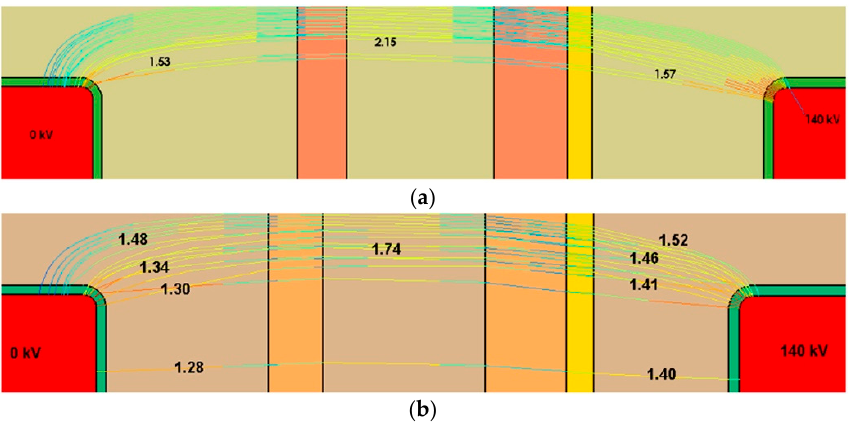
Figure 13. Safety factors, top terminal: ( a ) ester; ( b ) mineral oil.